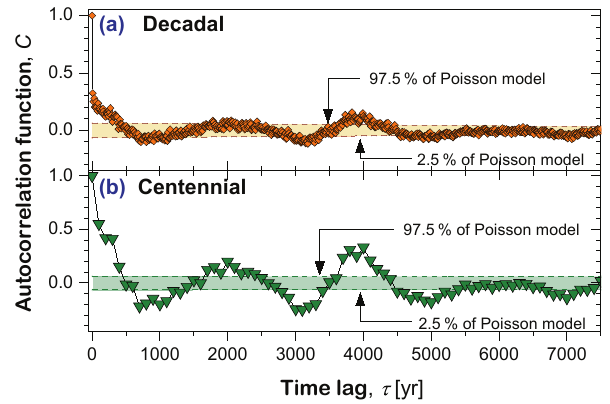
Figure 10. Autocorrelation analysis of the decadal and centennial palaeoflood records (see Fig. 3) and its Poisson model for lags of up to 7500 years. Autocorrelation function (ACF) (Eq. 5) of the number of floods per decade ( a , orange squares) and century ( b , green triangles). Also shown are the 97.5th and 2.5th percentiles, i.e. the upper and lower bounds of the 95% confidence interval, of the ACF (for lags τ> 0) of an uncorrelated signal with the same one- point probability distribution (i.e. realization of a Poisson model; see Sect. 3.2). See also Fig. 6b, which is a similar analysis, but only up to lags τ of 200